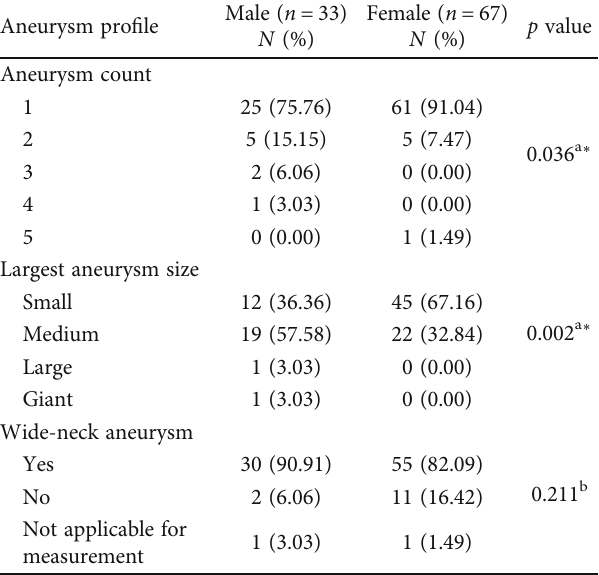
Table 3: Crosstabulation of aneurysm pro fi le and gender.